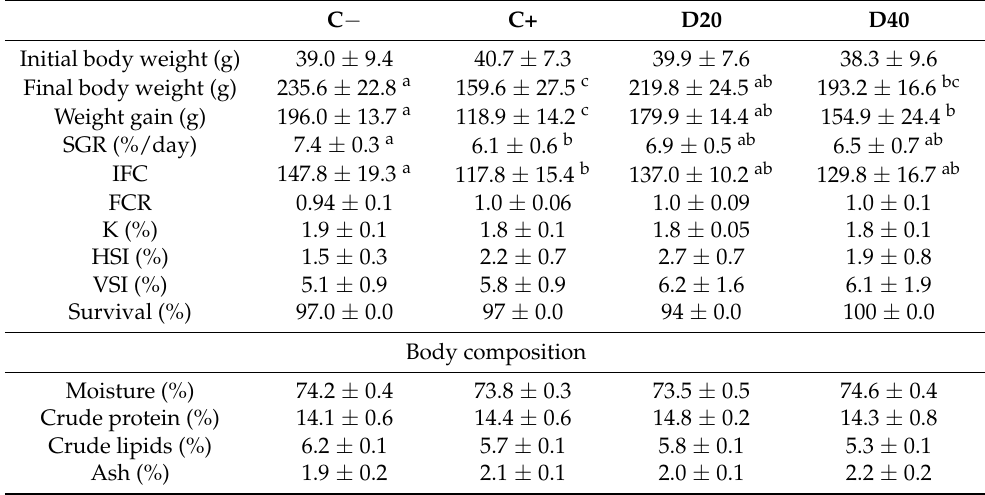
Table 3. Growth performance and body composition of Nile tilapia ( O. niloticus ) under high rearing density (63 kg/m 3 ) for 20